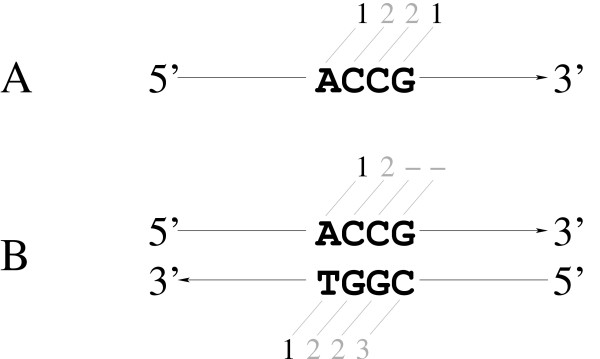
Shustrings on forward and backward strands. Global and local shortest unique substrings ('shustrings') in the DNA-sequence ACCG. A: The global shustrings are A and G, and have length 1 (black numbers above the sequence). The numbers above the sequence indicate the length of the four local shustrings A, CC, CG and G present on the forward strand. B: In the presence of the reverse strand global as well as local shustrings may change. For some positions at the 3'end of the sequence shustrings may not be defined (here, position 3 and 4 on the forward strand). Notice that the complement of a local shortest unique substring is also unique, however not necessarily a shortest unique substring (for example the pair GT on the reverse strand and AC on the forward strand). The complement of a global shortest unique substring is again a global shortest unique substring (here the two global shustrings A and T).